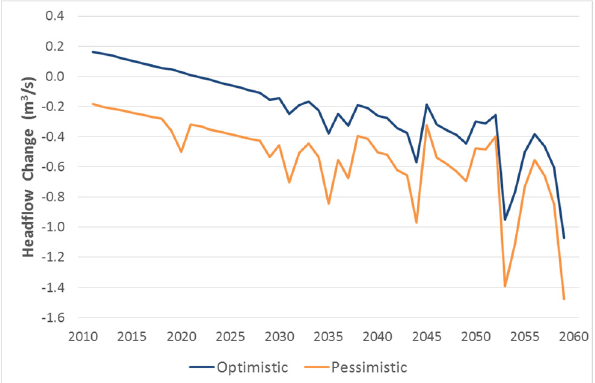
Figure 4. Average annual changes in headflows produced by páramo’s catchments of the Quiroz- Chipillico watershed model with respect to the reference